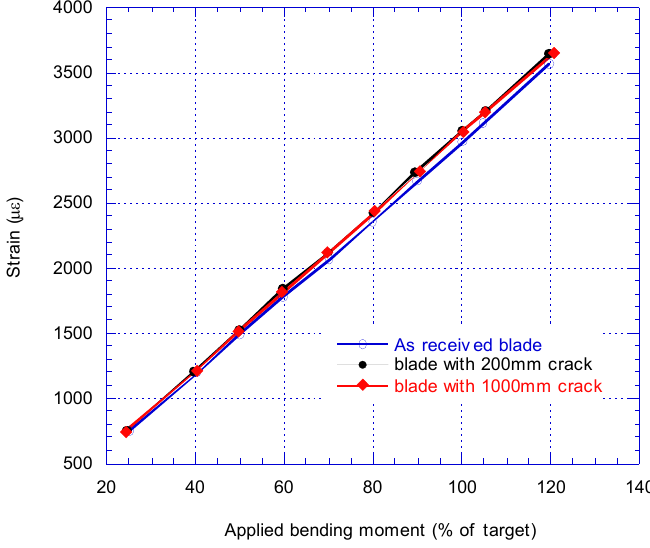
Figure 9. Comparison of bending moment from SG2 reading for three cases of the blade.